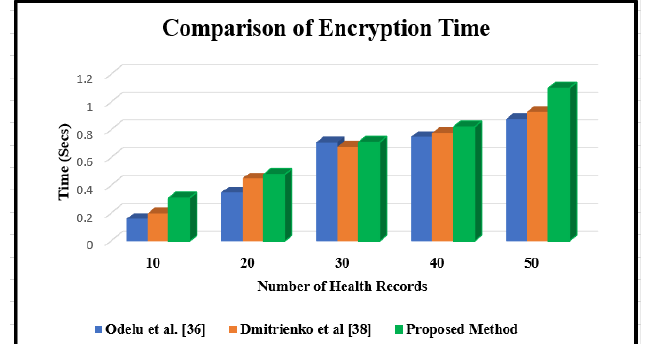
Figure 13. The encoding time in IoT